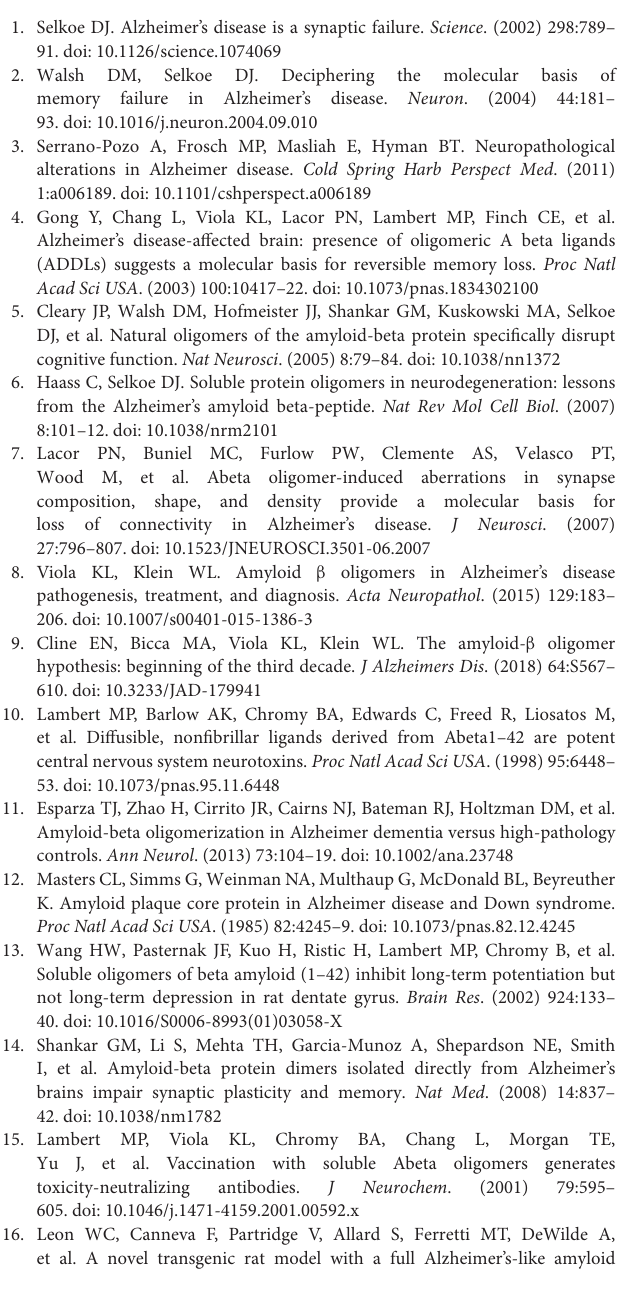
was 7.3U, and the protein concentration corresponding to the 1/2U max was 0.25 mg/ml ( n = 3). (B) Artificial ADDLs inhibited NKA activities in kidney cell membrane of mice at 0.25 mg/ml in reaction system ( n = 9). (C) Antibody D70 to oligomers of A β prevent artificial oligomers of A β at 1 µ M inhibiting activities of NKA of kidney cell membrane ( n = 3). (D) Soluble A β extracted from the cerebral cortex of human AD inhibited activities of NKA in kidney membrane of mice ( n = 3). (E) Antibody D70 to oligomers of A β prevent soluble A β extracted from the cerebral cortex of human AD inhibiting activities of NKA in kidney cell membrane of mice ( n = 3). Each value is expressed as mean ± SEM. ∗ p < 0.05, ∗∗ p < 0.01, ∗∗∗ p < 0.001, # p <